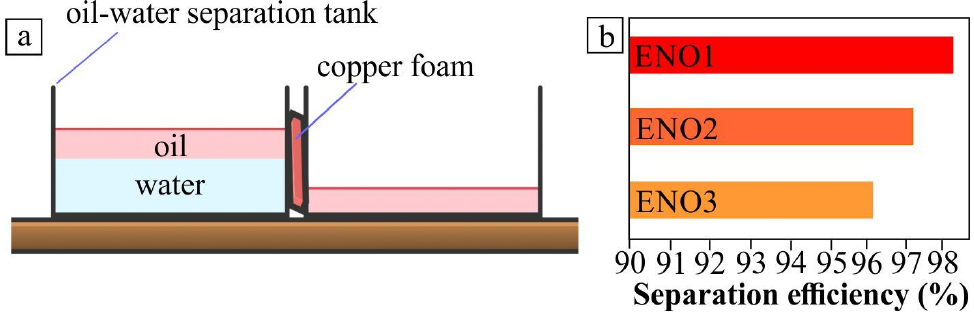
Figure 7. ( a ) Oil/water separation process, ( b ) separation efficiency for different engine oils.